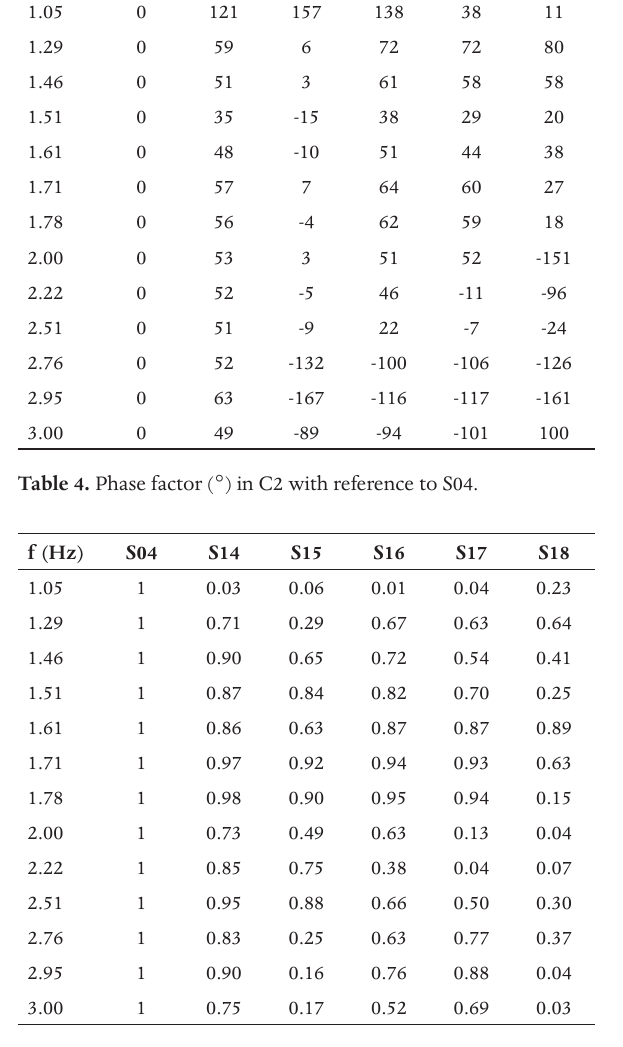
Table 5. Coherence function in C2 with reference to